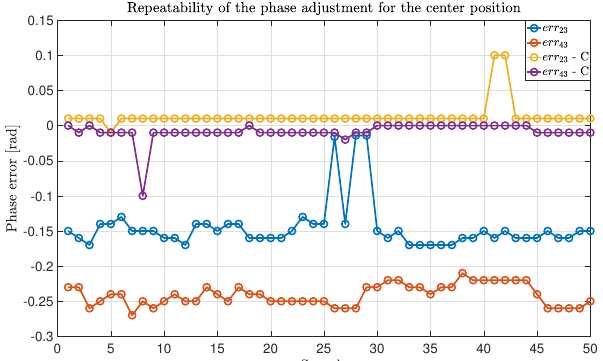
Figure 7. Analysis of the repeatability of the phase adjustment for the center position on 50 experimental samples, with err ij representing the absolute error committed for the antenna elements { ij } without compensation and err ij -C the absolute error committed with the compensation